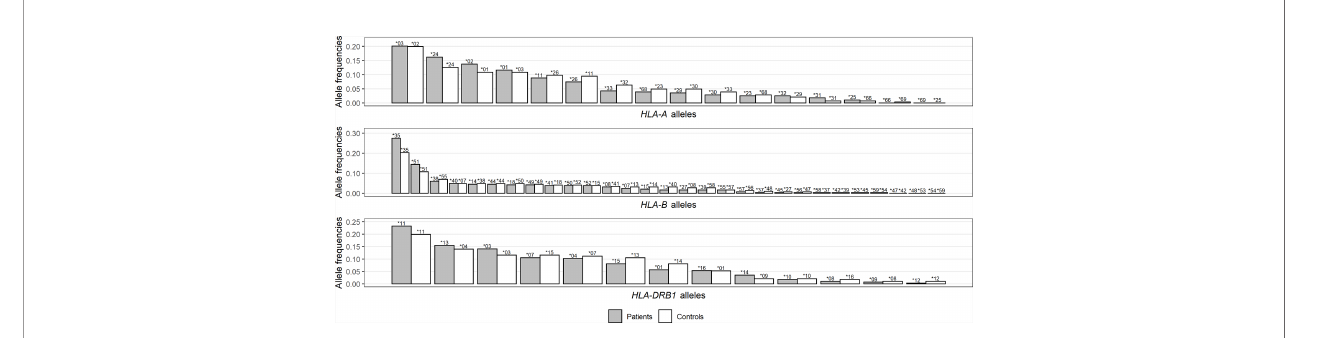
FIGURE 1 | Distribution comparison of allele frequencies for HLA-A (A) , -B (B) , and -DRB1 (C) loci between patients and controls. Noting that HLA alleles for each group are ranked by frequencies and represented by bars of different lengths with their names on top, each bar pair does not necessarily correspond to the same